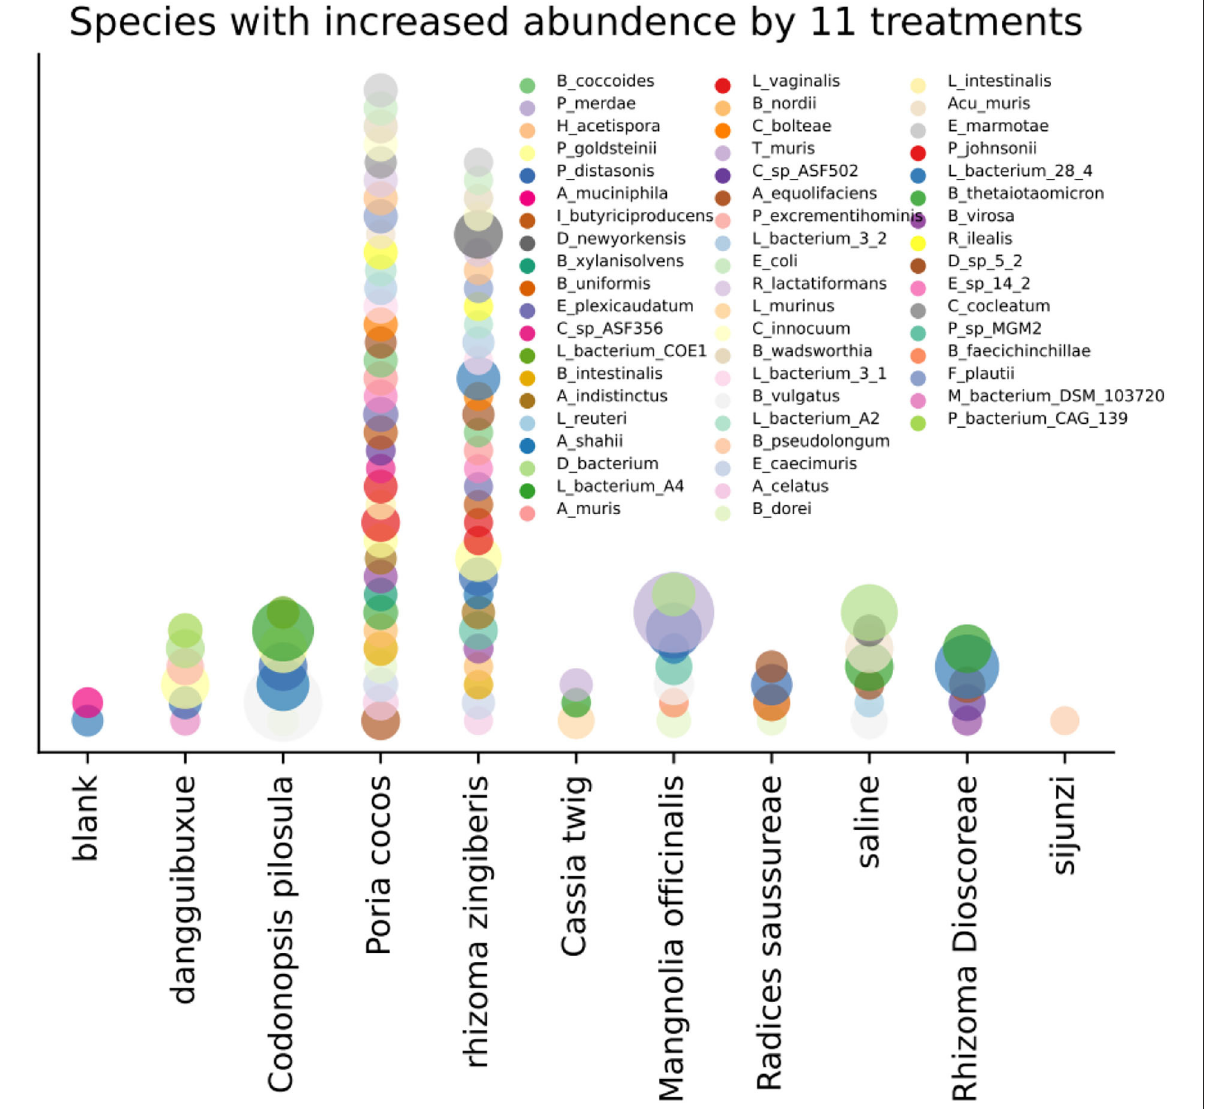
FIGURE2 Increase in species abundance by the 11 treatments, where p 2 < 0.025 with the one-tail